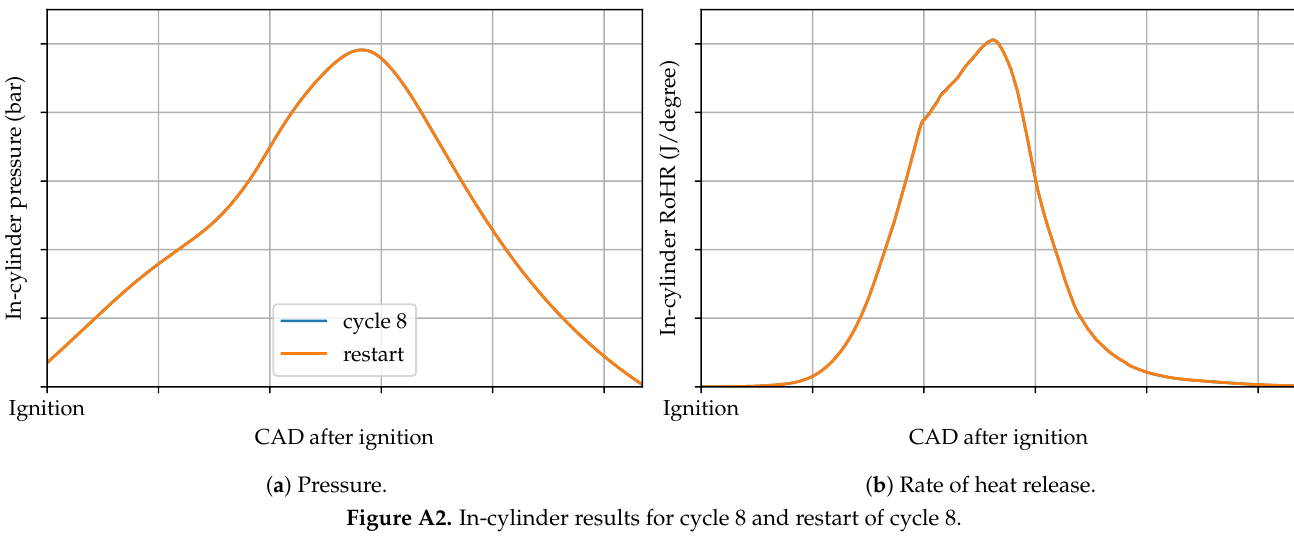
( b ) Rate of heat release.